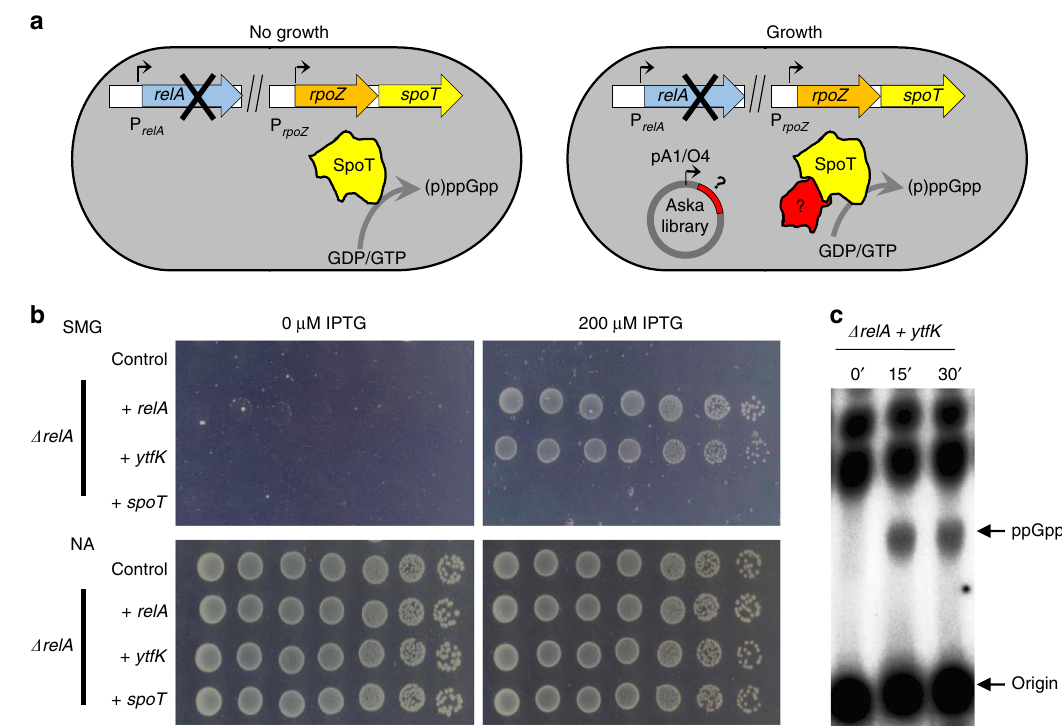
Fig. 1 YtfK promotes SpoT (p)ppGpp synthesis. a Genetic setup based on the multicopy suppression (ASKA library) of the nongrowing phenotype of Δ relA mutant on SMG plates. SMG plate induces isoleucine starvation and requires high (p)ppGpp level to de-repress isoleucine biosynthesis operon (see the Methods section). Question mark denotes putative candidate that promotes SpoT-dependent (p)ppGpp accumulation. b ytfK overexpression suppresses the nongrowing phenotype of the Δ relA mutant on SMG plates. WT and Δ relA mutant were transformed with pEG25 harboring either relA , ytfK , or spoT under an IPTG-inducible promoter. Cells were serial diluted and spotted both on nutrient agar (NA) and SMG plates with or without IPTG. This experiment was repeated fi ve times with identical results. Additional controls and concentration of IPTG are provided in Supplementary Fig. 1. c In vivo (p) ppGpp accumulation following ectopic expression of ytfK . Δ relA mutant carrying ytfK on pEG25 was grown exponentially in phosphate MOPS minimal medium (see the Methods section). Samples were collected before and after ytfK induction (1 mM IPTG) prior to nucleotide extraction and separation by TLC. Representative autoradiograph of the TLC plates is shown. This experiment was repeated three times with equivalent pattern of (p)ppGpp accumulation. Source data are provided as a Source Data fi